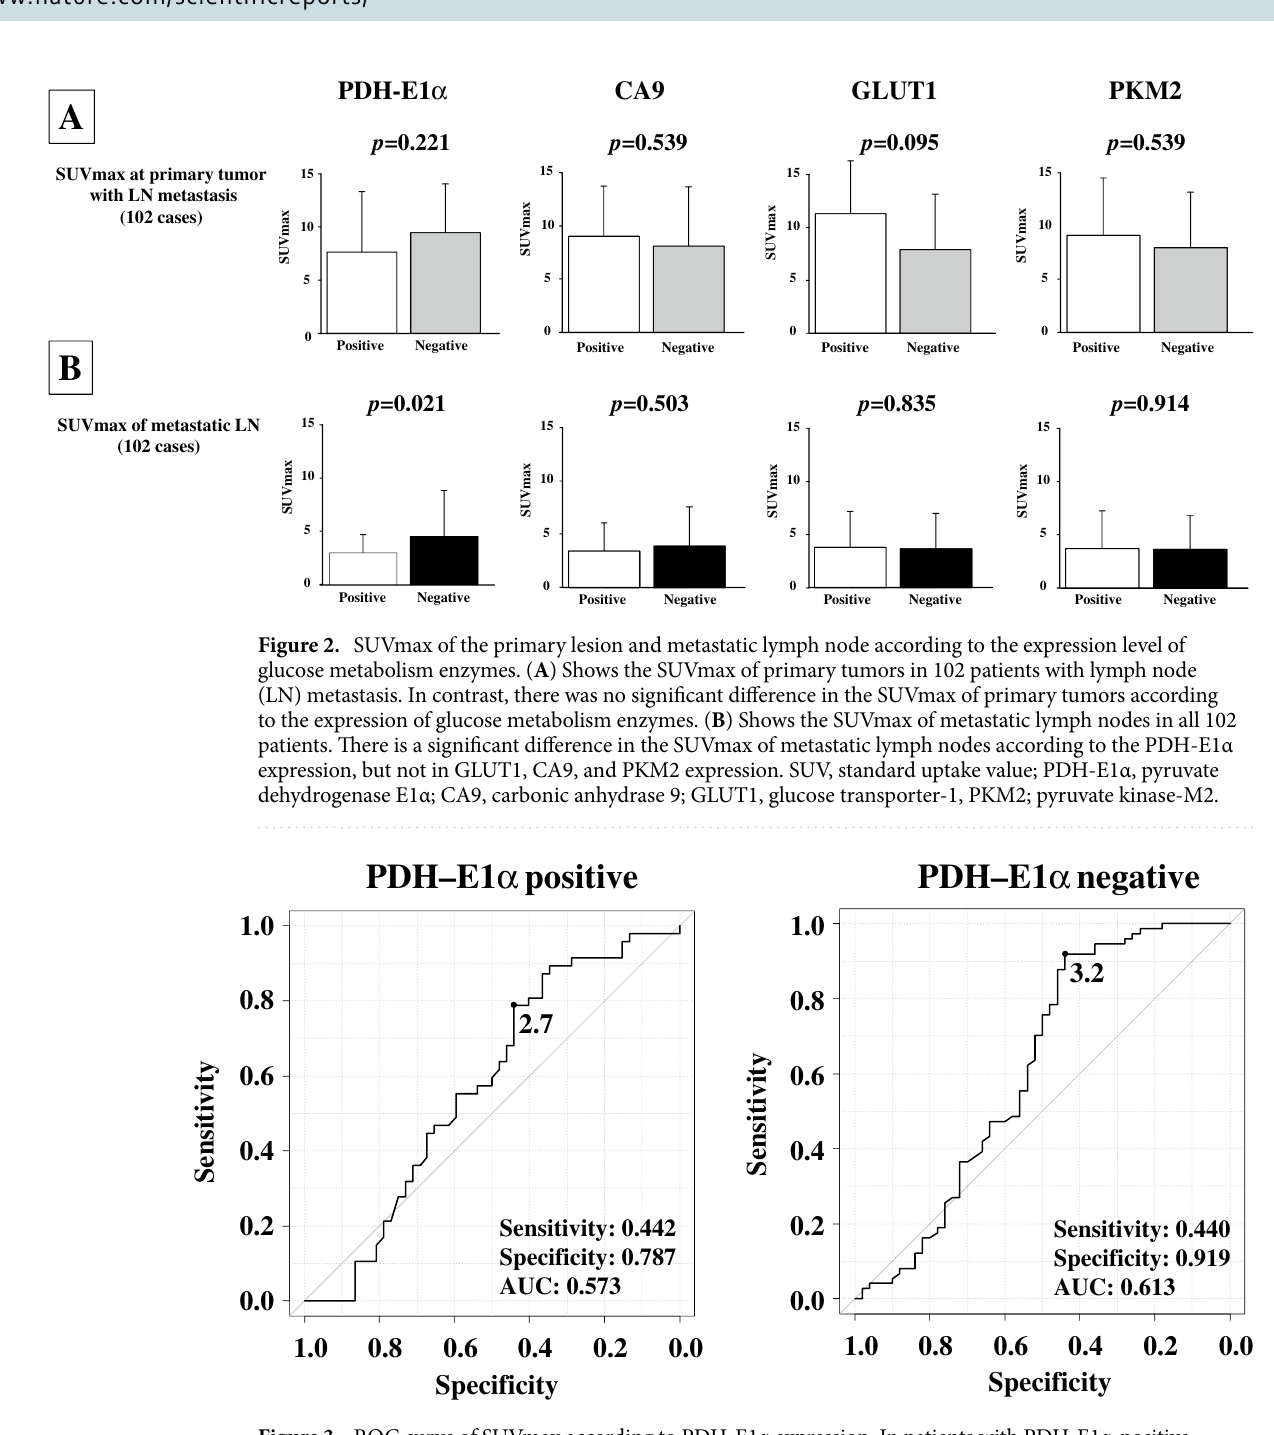
Figure 3. ROC curve of SUVmax according to PDH-E1α expression. In patients with PDH-E1α-positive primary tumors, the optimum cut-off value of SUVmax was 2.7 and AUC was 0.573. In contrast, in patients with PDH-E1α-negative expression tumors, the optimum cut-off value of SUVmax was 3.2 and AUC was 0.613. SUV, standard uptake value; PDH-E1α, pyruvate dehydrogenase E1α; ROC, receiver operating characteristic; AUC, area under the